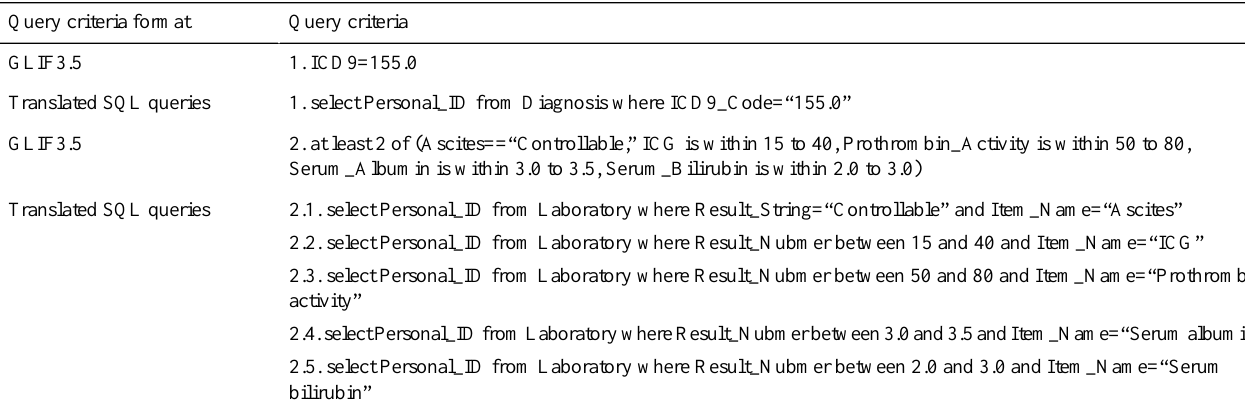
Table 1. The examples of the query criteria in GLIF3.5 and the corresponding translated SQL queries. Query criteriaQuery criteria